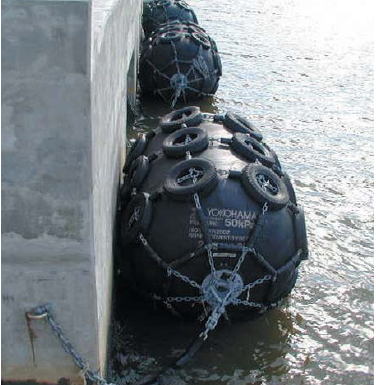
Figure 3. Pneumatic fenders.